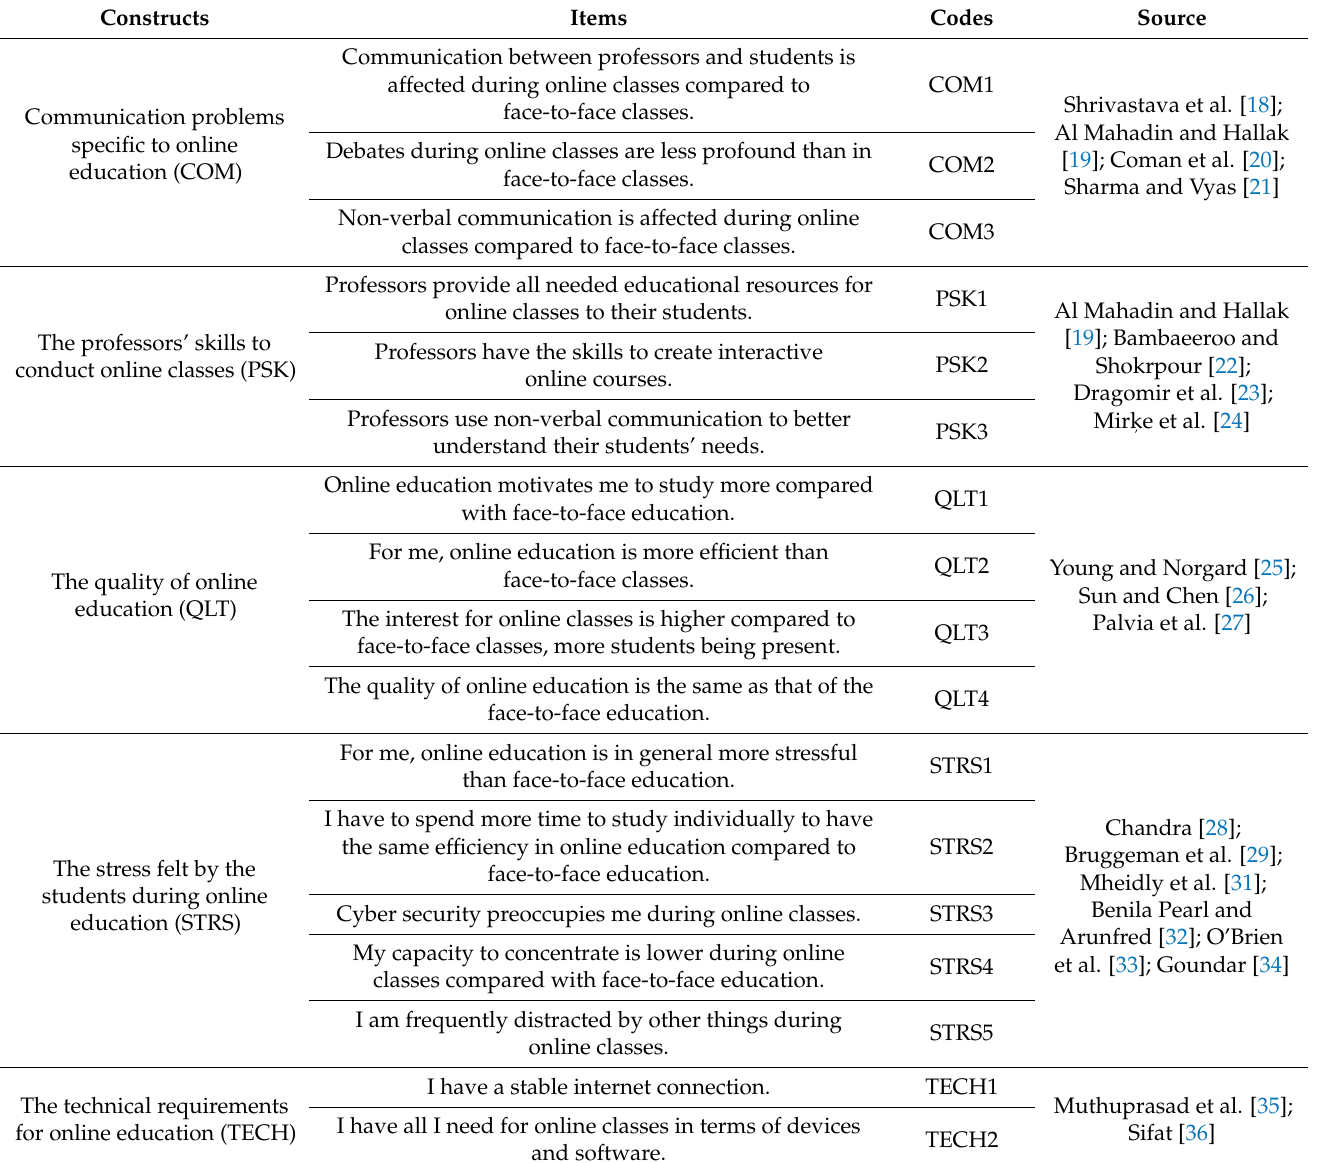
Table 1. The constructs, items, and codes used in the research